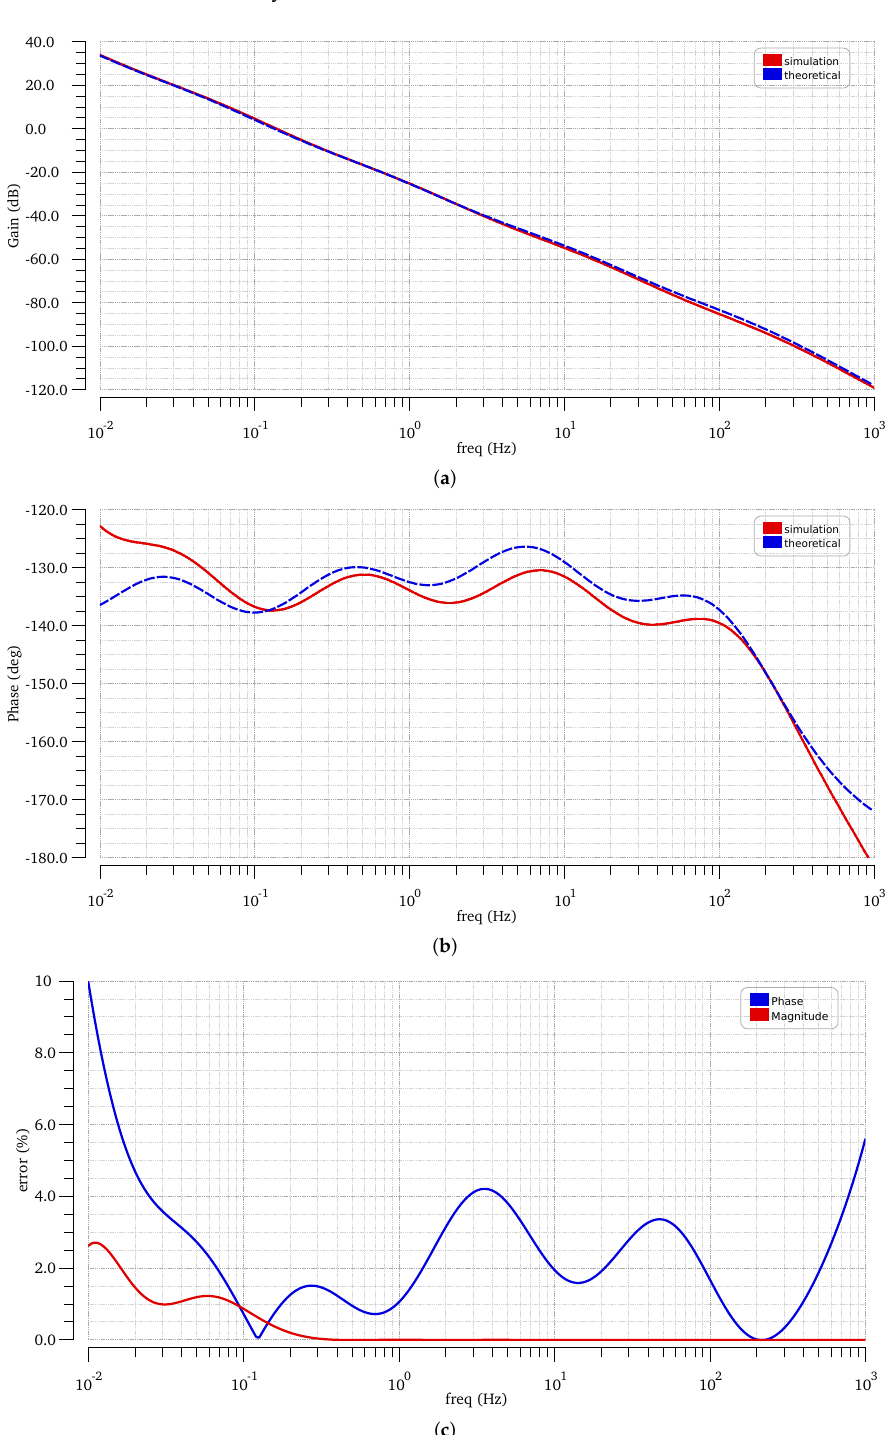
Figure 7. Frequency responses of ( a ) magnitude, ( b ) phase, and ( c ) error of magnitude and phase of the open-loop controller-plant